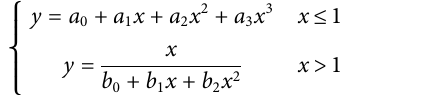
Frontiers in Materials |